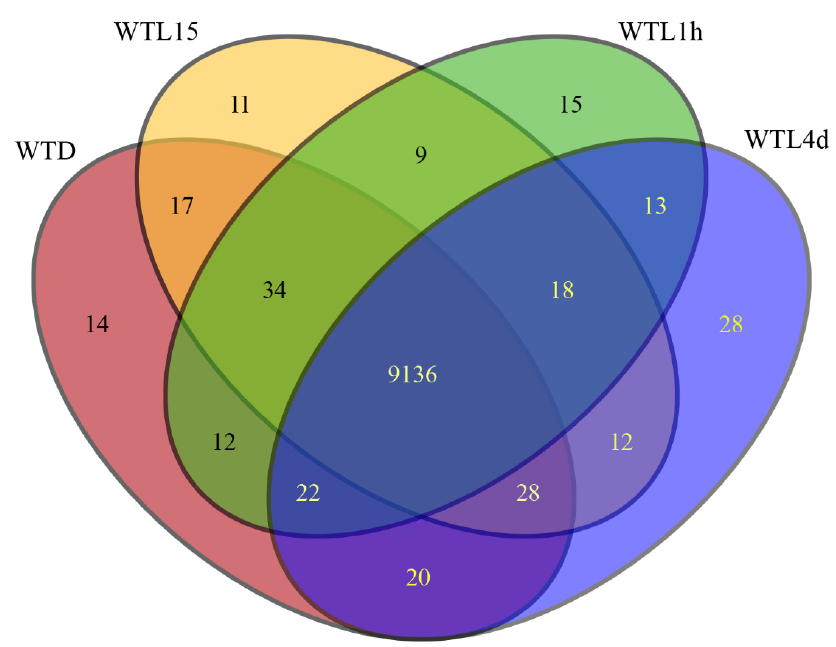
Figure 1. Venn diagram of transcribed genes in transcriptomes of Cordyceps militaris with different light exposure time.